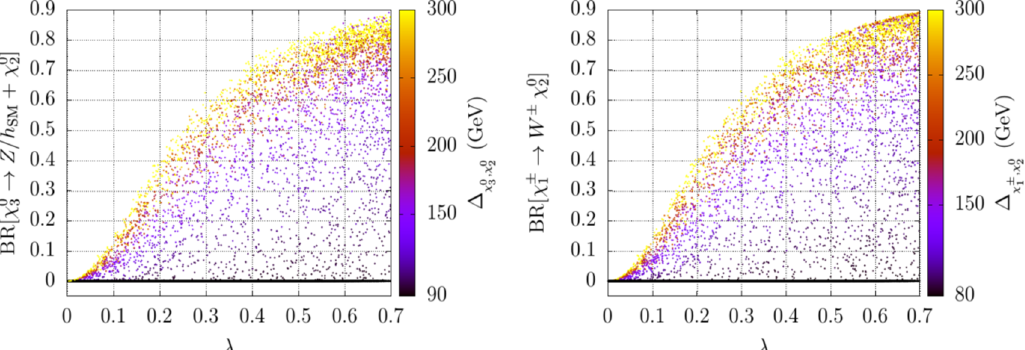
] (left) and BR[ χ ± ] → Z/h SM + χ 0 → W ± χ 0 3 2 1 2 = m (left) and ∆ = m (right). Palettes − m − m χ 0 ,χ 0 χ ± 1 ,χ 0 χ 0 3 χ 0 2 χ 0 2 χ ± 1 3 2 2